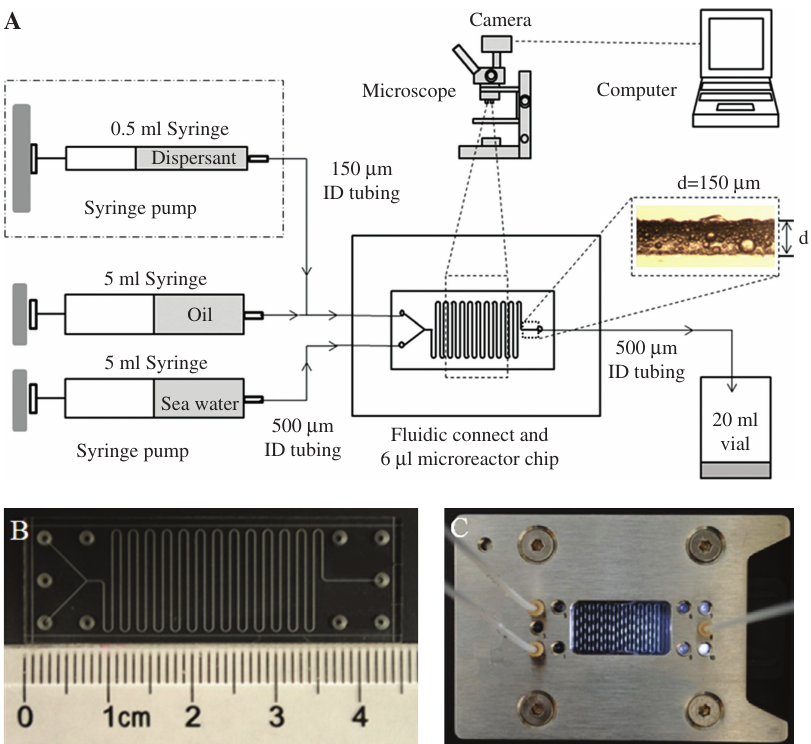
Figure 1 (A) Schematic flow diagram of the experimental setup used to study the stability of mineral oil-seawater multiphase flows in the presence of model dispersants. Photographs of (B) the enlarged 6- μ l microfluidic chip and (C) the packaged system with fluid delivery and exiting connections are also